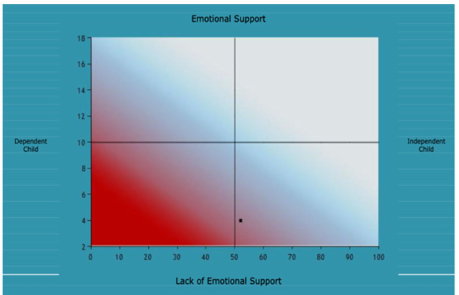
Figure A7. Joanna and Mrs. Townsend.